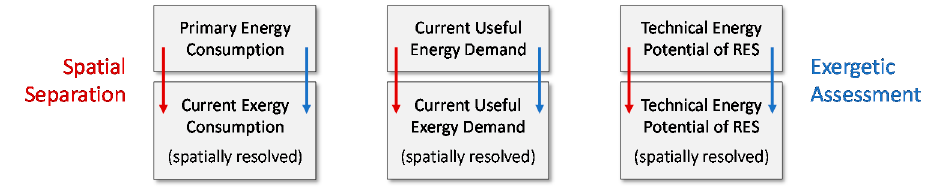
Figure 4. The spatial separation, as well as the exergetic assessment, is required for each of the three exergy amounts.